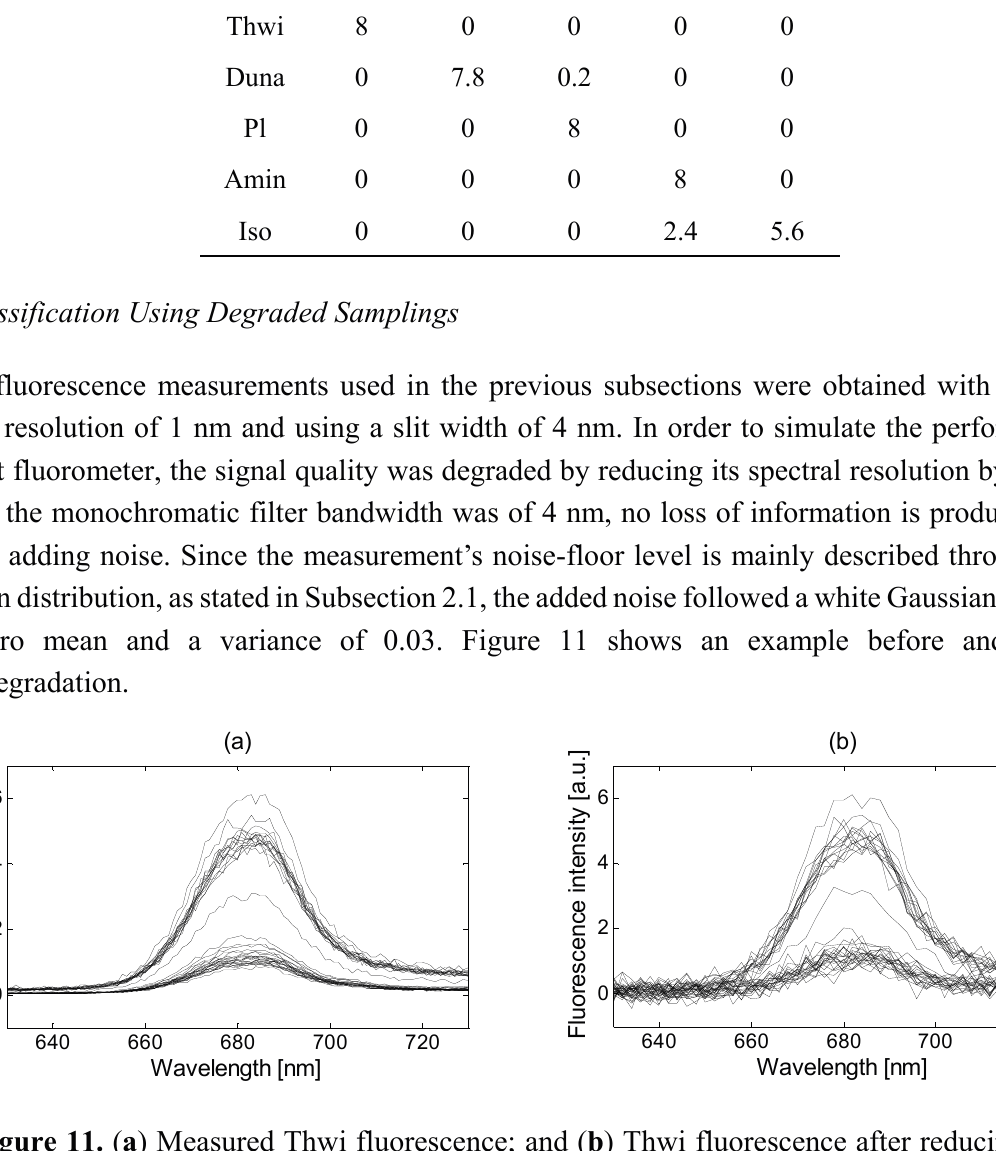
Table 10. Averaged confusion matrix obtained with the self-organizing maps (SOM) algorithm when using the wavelet (soft threshold) and the Min-Max methods to denoise and normalize. Results of the confusion matrix have been averaged due to the five-fold cross-validation. Thwi Duna Pl Amin Iso